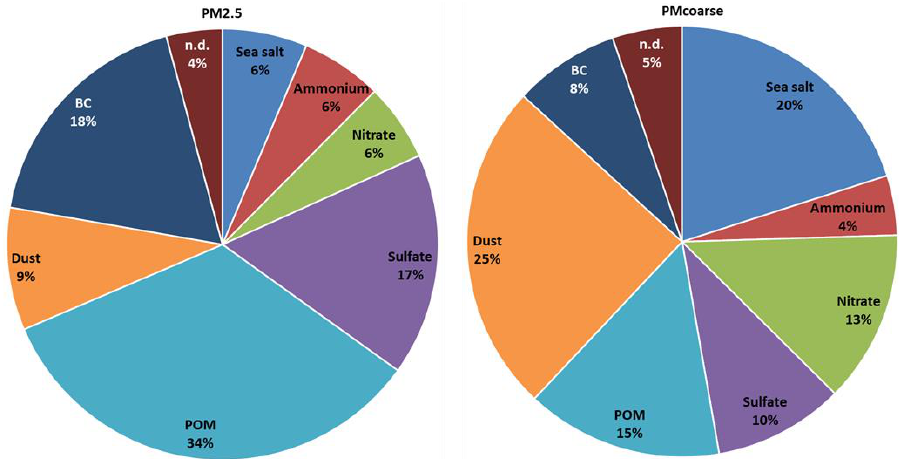
Figure 2. Contributions (%) of different components to the total masses of PM 2.5 and PM coarse from a 12-month average of the Tetouan experiment.